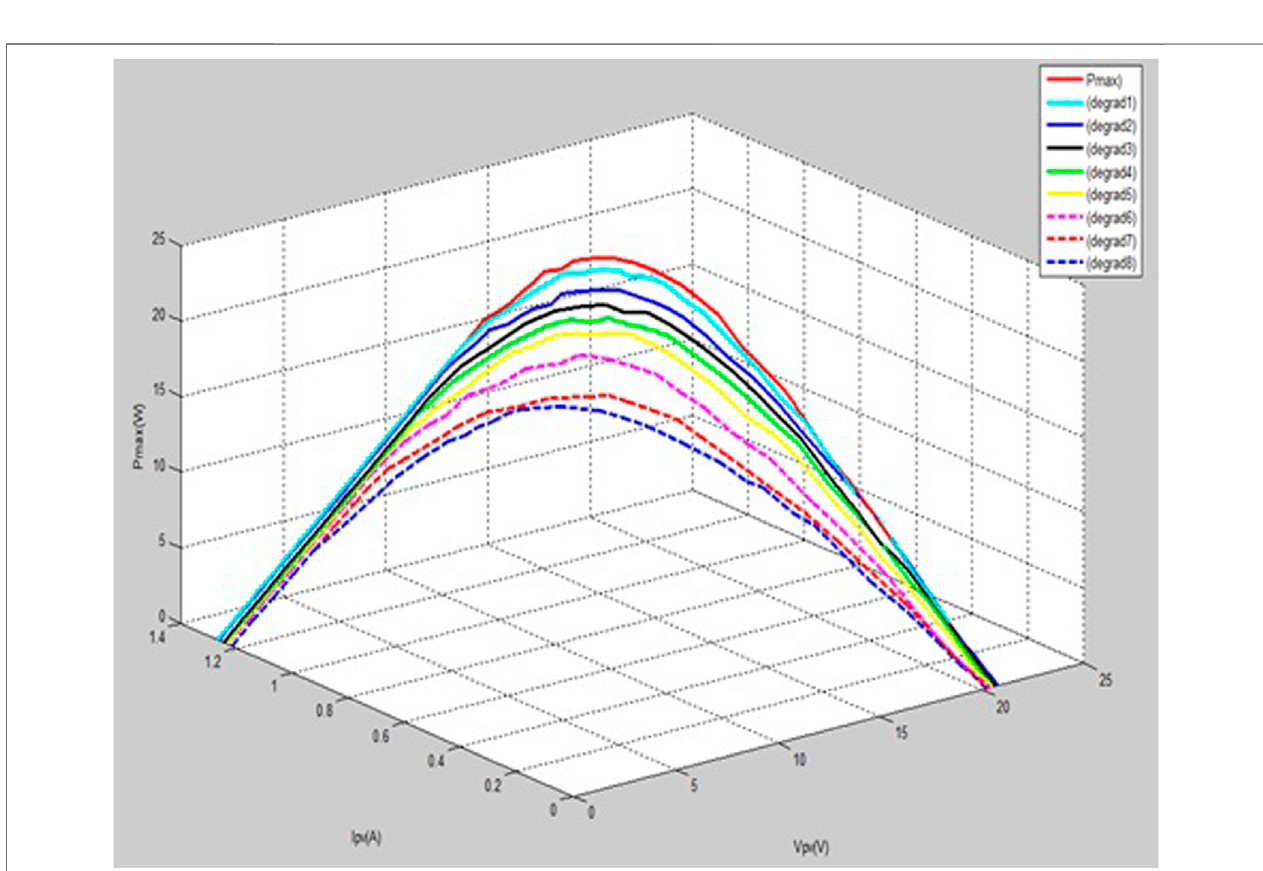
FIGURE 14 | Power (W) against current (A) and voltage (V) illustrating various MPP in 3D.